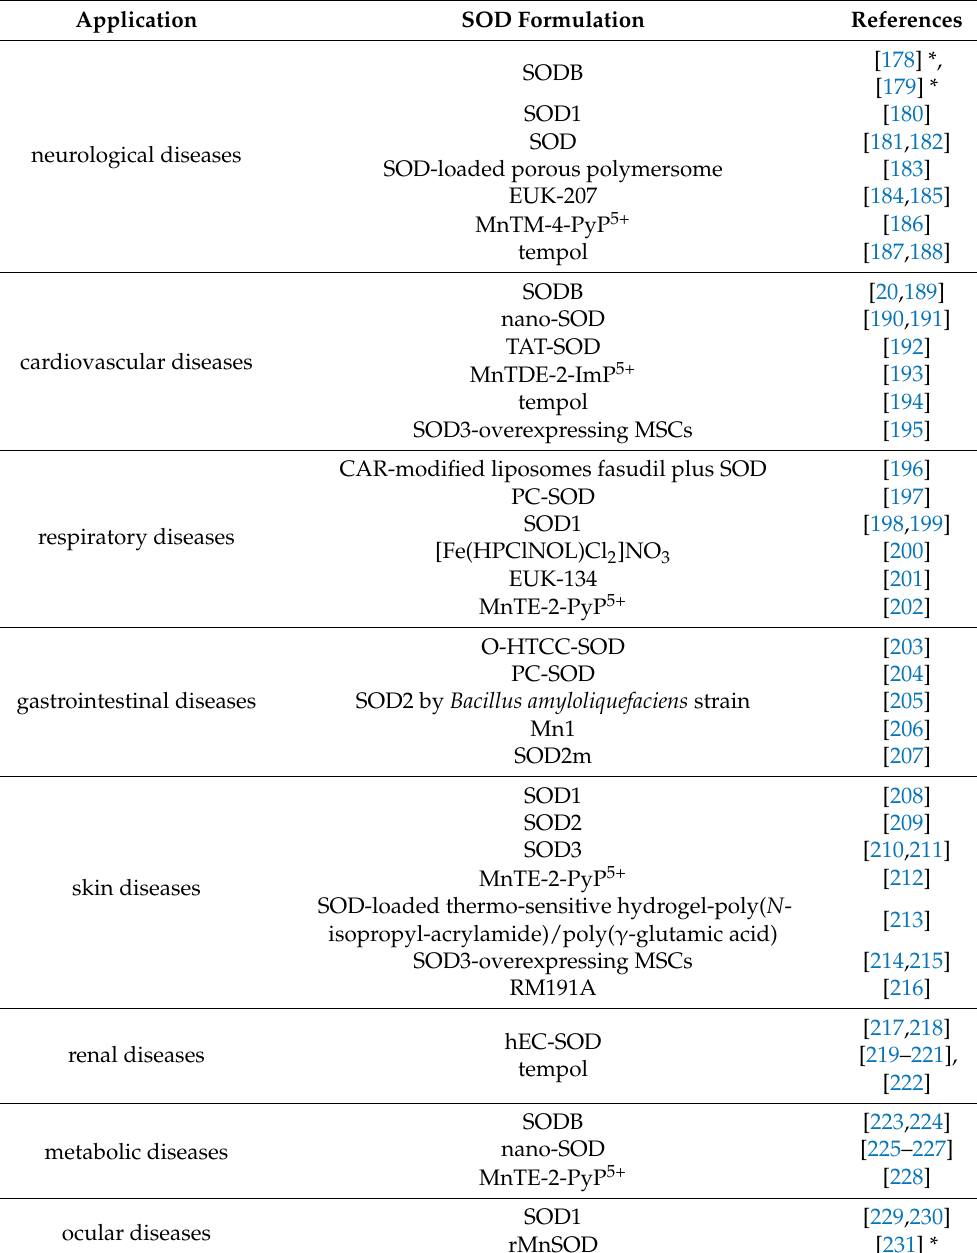
Table 2. Potential SOD applications tested in animal models of human disease and clinical trials between 2012 and